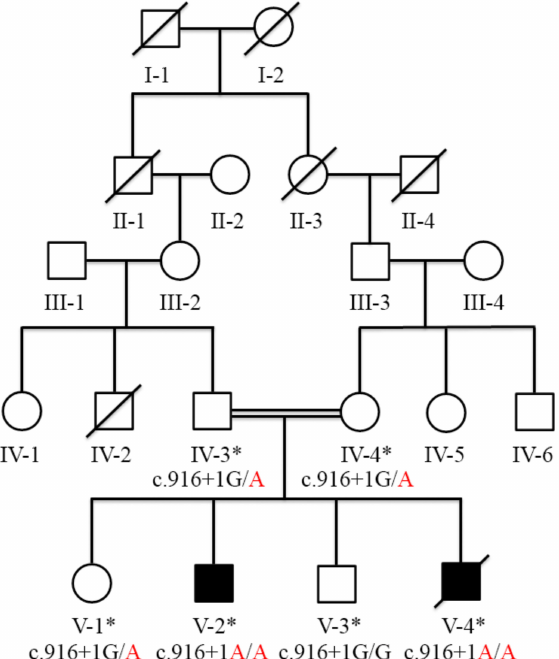
Figure 1. Pedigree of the family showing the segregation of the ARMC3 variant in an autosomal recessive manner. Empty squares and circles show the unaffected males and females, respectively. The filled shapes show the affected individuals. The symbols labeled with asterisks show the individuals who participated in this study. Affected members (V-2 and V-4) showed a homozygous mutant genotype (A/A). Phenotypically unaffected individuals IV-3, IV-4, and V-1 were heterozygous (G/A), while V-3 showed the wild-type genotype